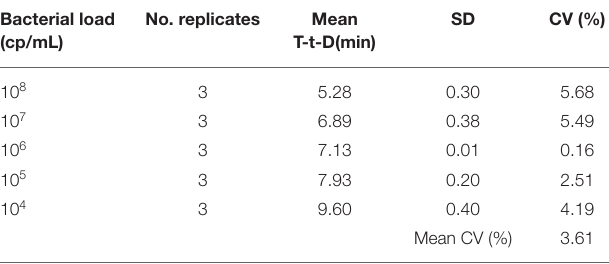
TABLE 2 | Results of precision (intra-assay variability) for the LAMP assay. Bacterial load (cp/mL)